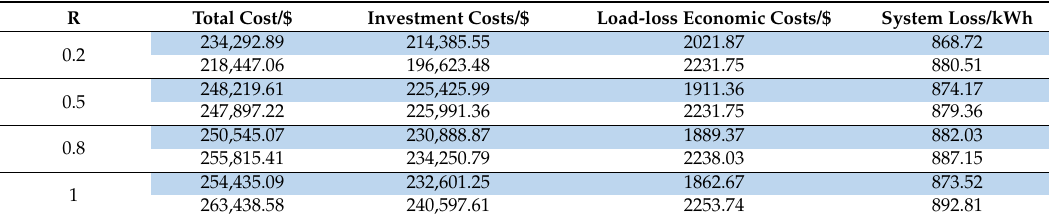
Table 3. Comparison of the two planning schemes under different R